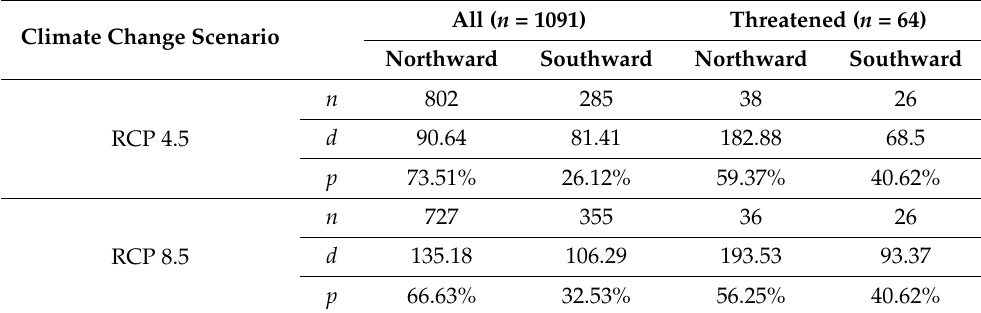
Table 4. Species range centroid shift ( n = no. of species, d = distance shift in Km, p = % species). All ( n = 1091) Threatened ( n = 64) Climate Change Scenario Northward Southward Northward